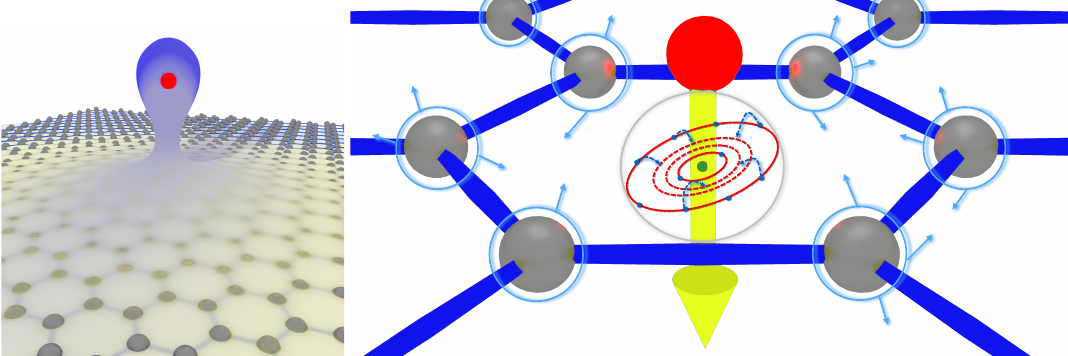
Figure 8. (Color online) ( left ) The approaching HCI extracts electrons from the target surface while it is still at large distances. Electrons are captured in highly excited states as a result of resonant charge transfer. A hollow atom is formed. ( right ) At close collisions with target atoms, ICD leads to rapid quenching of the hollow atom and the emission of a large amount of low energy electrons from the target